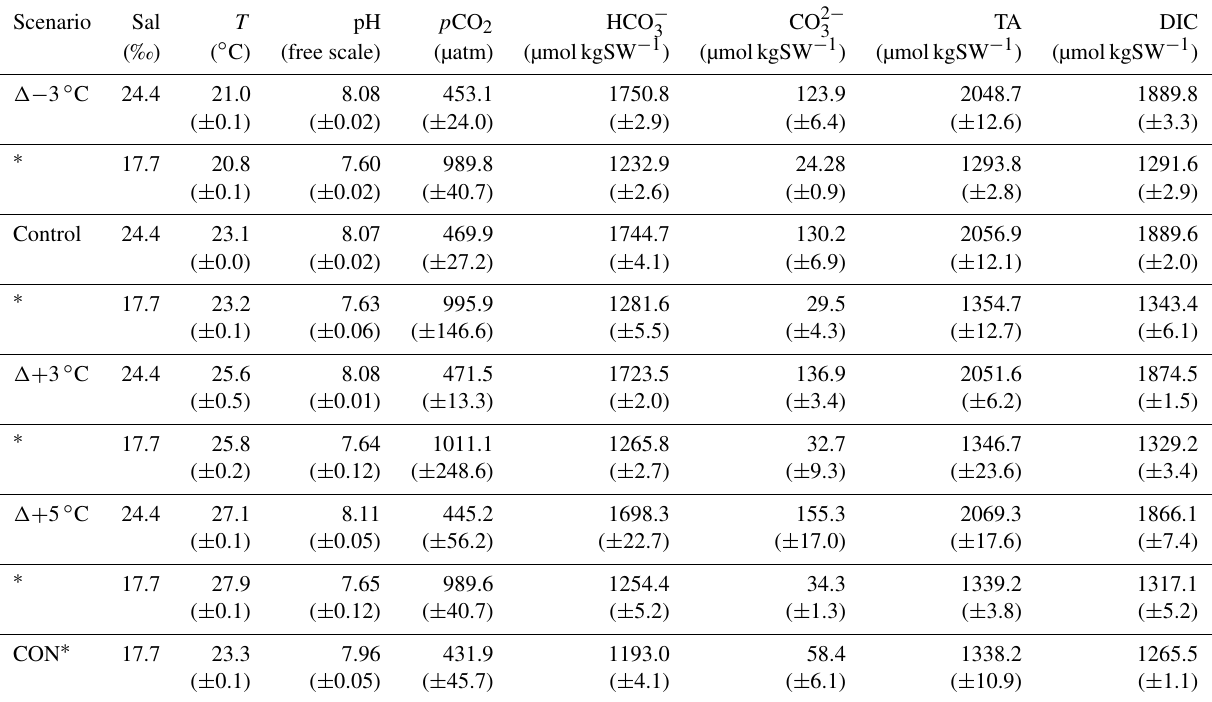
Table 1. Start conditions for incubations at current and high p CO 2 levels ( ∗ ) showing mean ( ± SD) of various carbonate parameters. CON ∗ is the overlapping control core present in the high- p CO 2 incubation